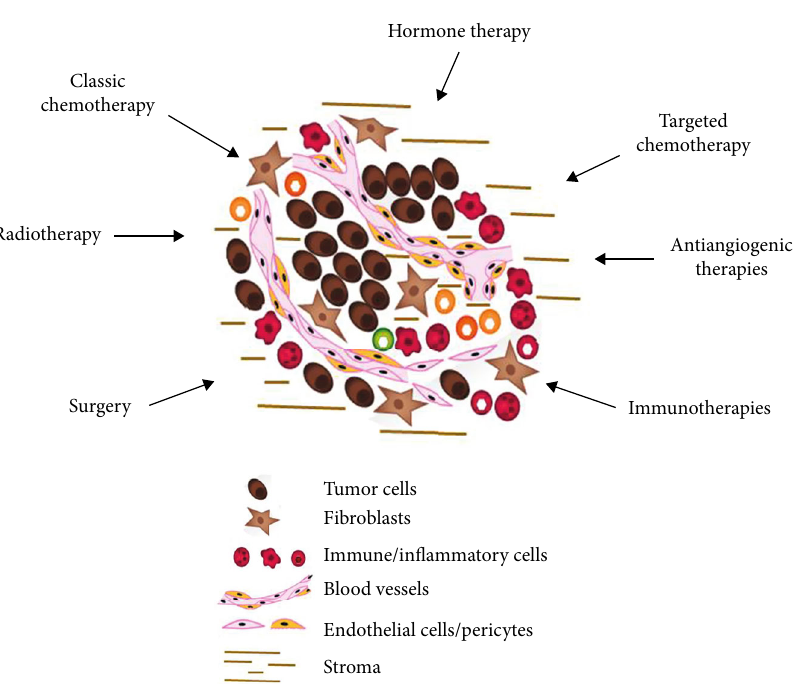
Figure 1: Therapeutic approaches currently used in cancer treatment. According to the “ tumor-centric ” paradigm, a cancer cure is only achieved after the complete eradication of the tumor